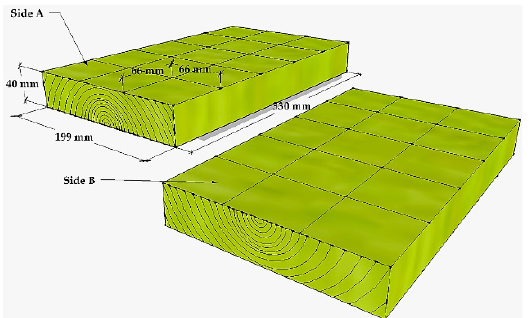
Figure 3. Scheme of distribution of area of the test sample to the individual measuring places.